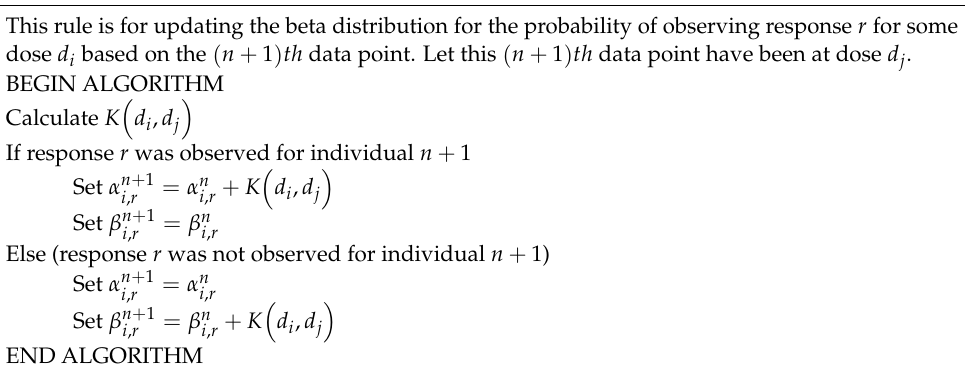
Algorithm 2. (Continuous) Correlated Beta Process Update Rule